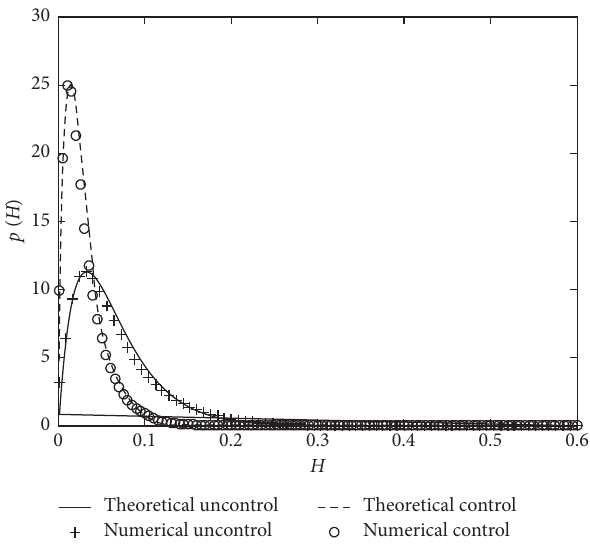
Figure 3: Stationary probability density p ( H ) of controlled and uncontrolled system